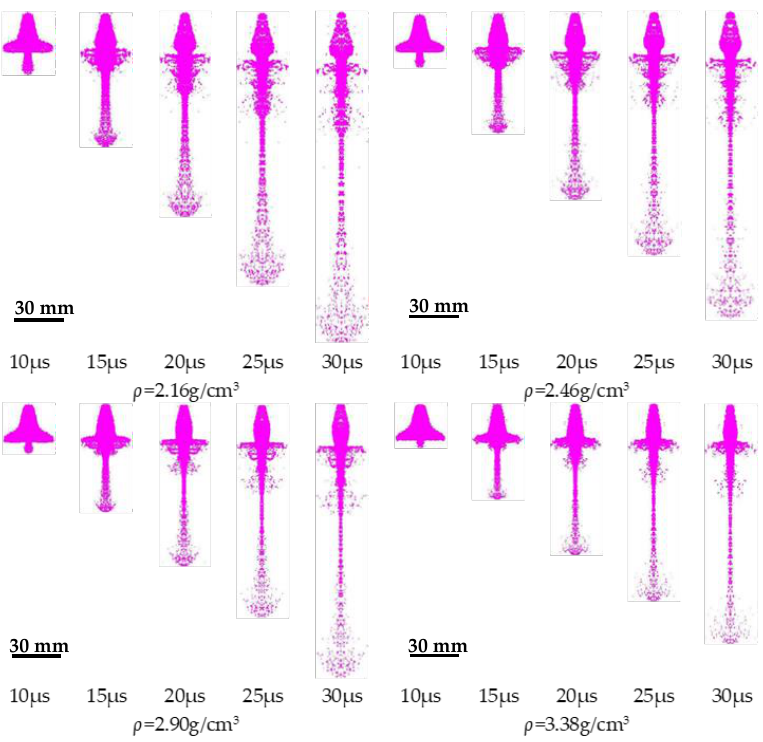
Figure 12. Jet forming process of liner with different densities.